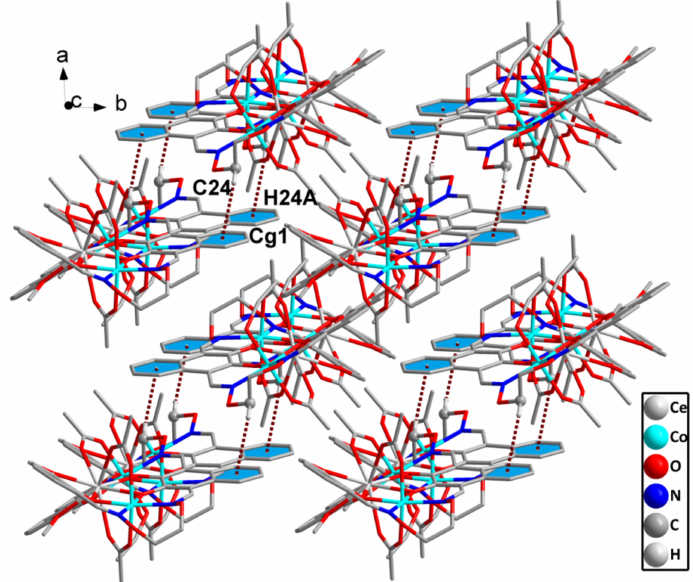
Figure 8. View of 2D supramolecular structure by C–H ··· π interaction of the Co(II)-Ce(III)